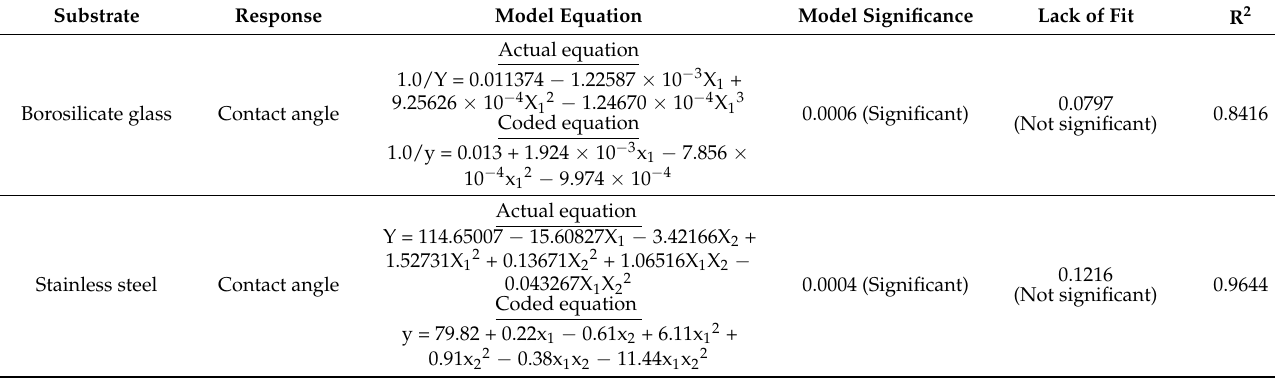
Table 4. Model equations fitted for contact angle experimental data for PDMS surface coating on borosilicate glass and stainless steel substrates.